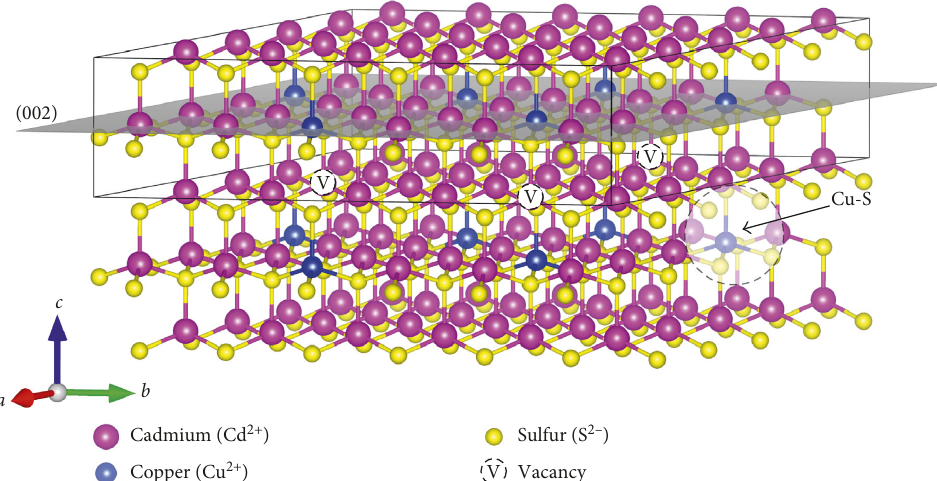
Figure 6: Schematic distribution of the Cu 2+ atoms over the (002) plane within crystalline structure of